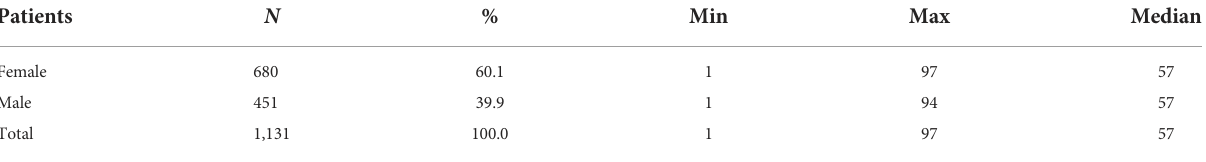
TABLE 2 Demographic information of the study